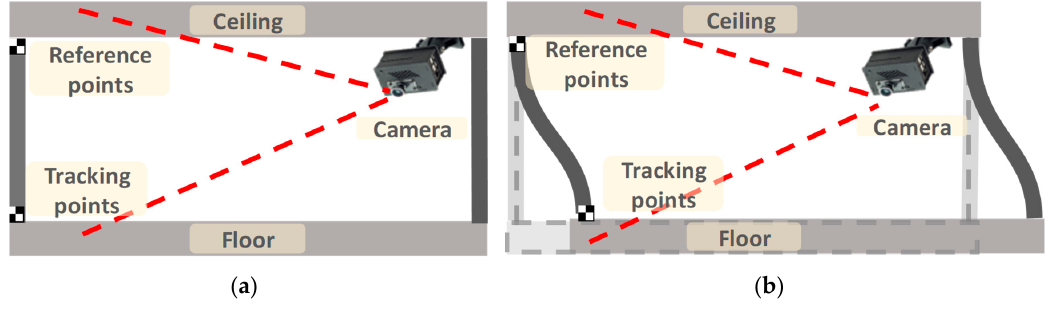
Figure 3. A 2D inter-story response monitoring using a single camera. ( a ) Without inter-story displacement. ( b ) With inter-story displacement.